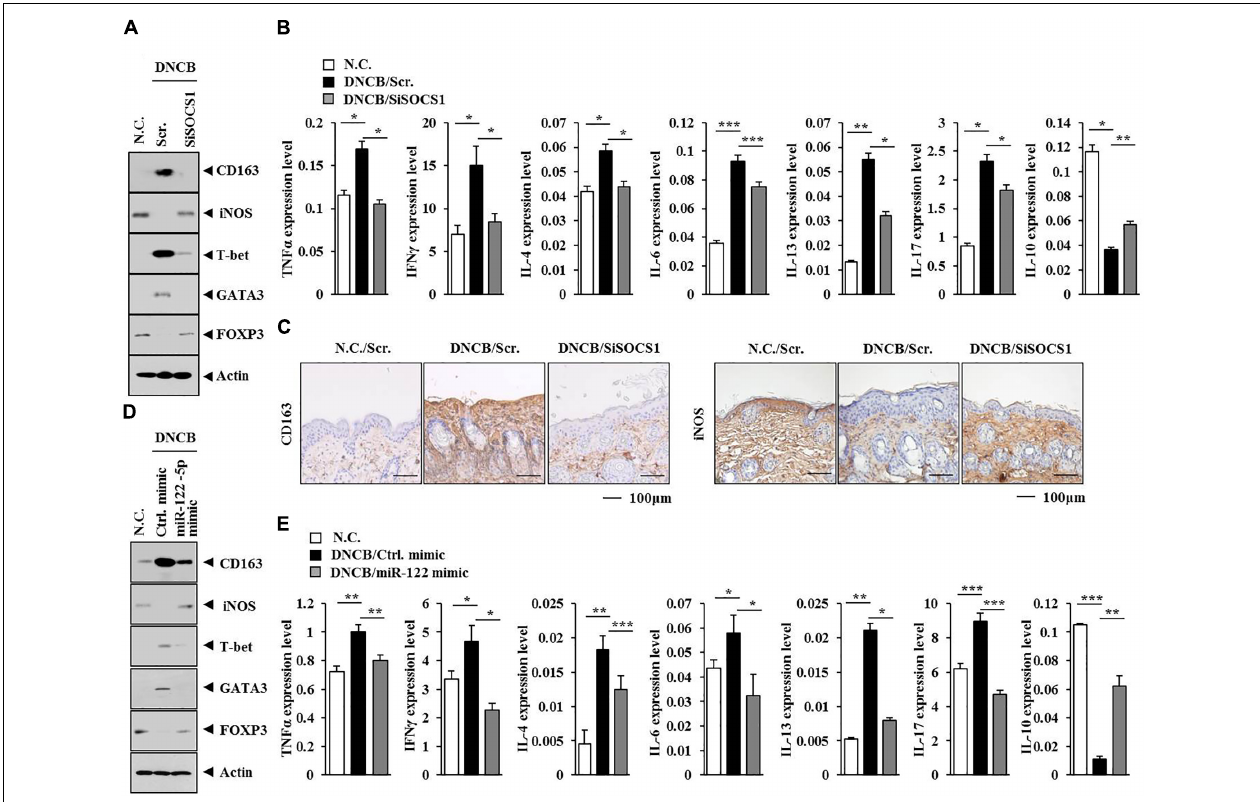
FIGURE 13 | miR-122a-5p-SOCS1 negative feedback loop regulates TH1/TH2 and regulatory T (Treg) response during AD. (A,D) Tissue lysates from the mice of each experimental group were subjected to western blot analysis. (C) Skin tissues of BALB/c mice of each experimental group were subjected to immunohistochemical staining. Scale bar represents 100 µ m. (B,E) Tissue lysates from the mice of each experimental group were subjected to qRT-PCR analysis. ∗ p < 0.05; ∗∗ p < 0.005; ∗∗∗ p <